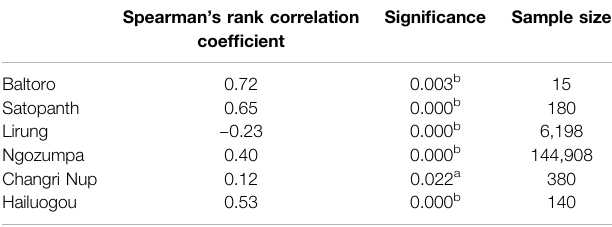
TABLE 1 | Correlations between the debris thickness/surface temperature datasets, for each